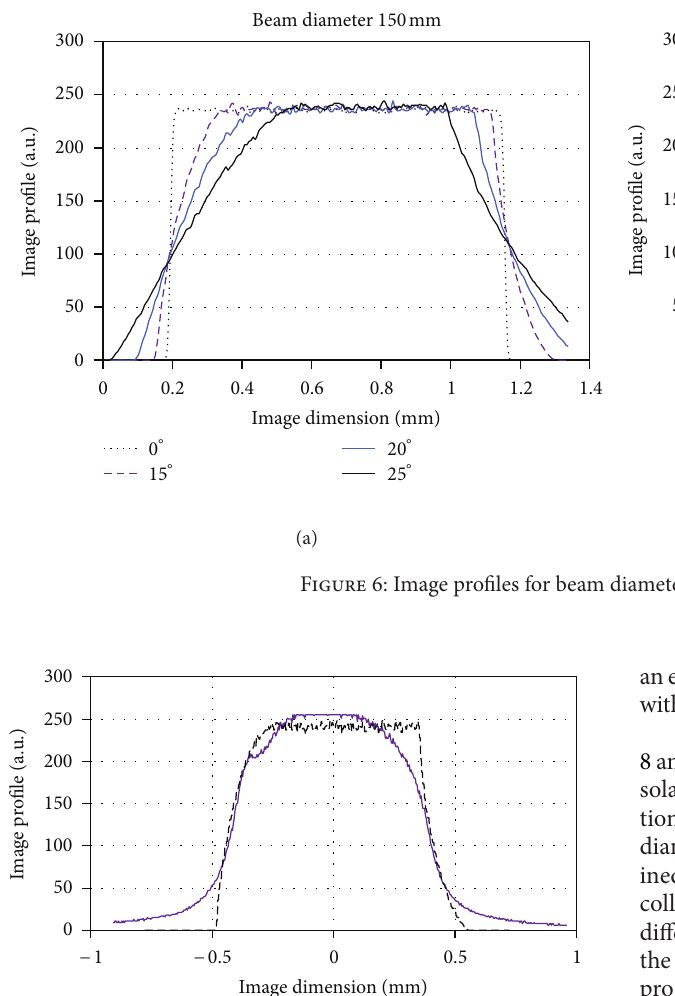
be considered 210 mm, while high accuracy measurements should be performed within the diameter of 180